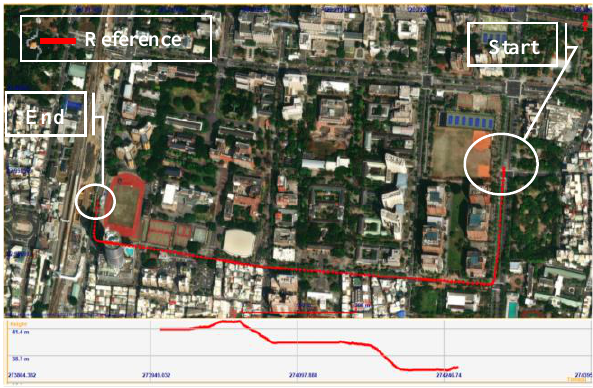
Figure 9. Test field under urban area.